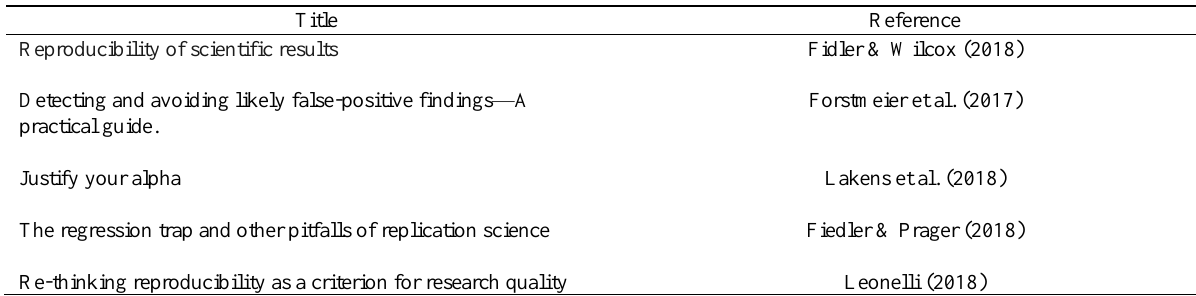
Recommended Reading to Introduce Readers to Current topics in Replication